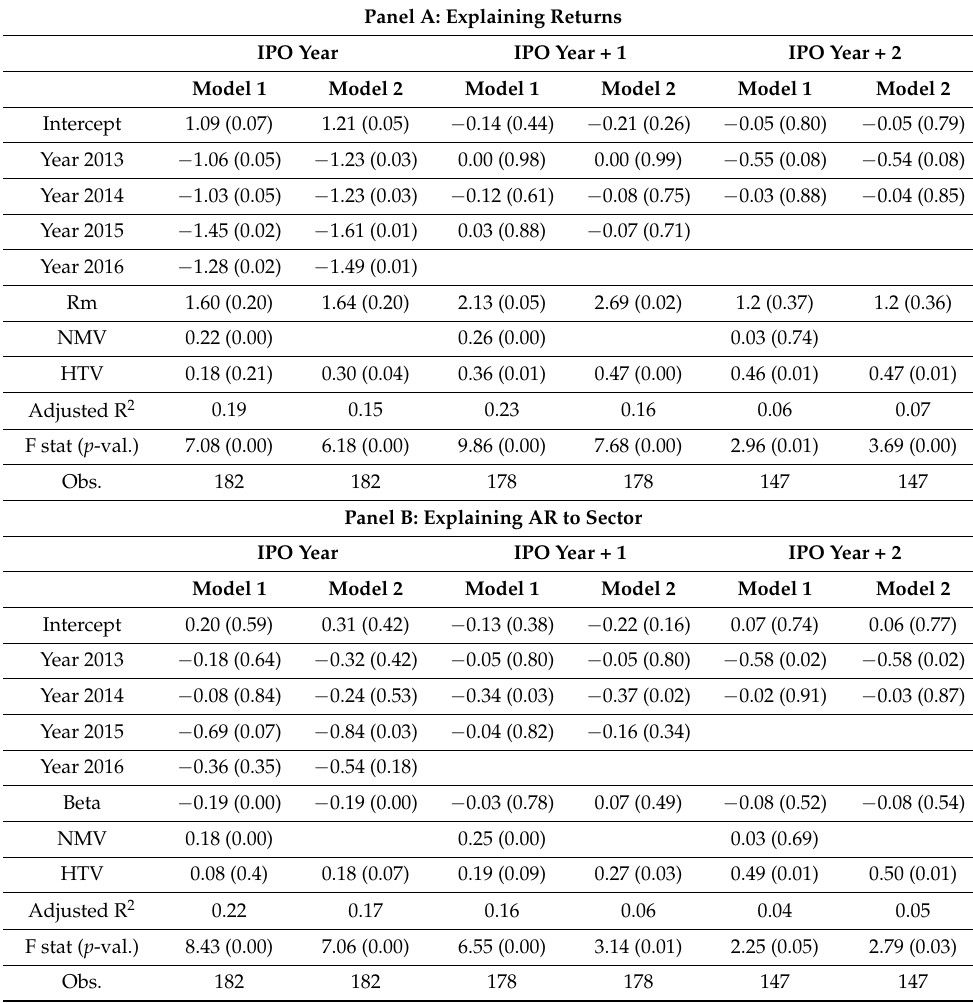
Table 6. The Effects of Tweet Volumes on Returns and Abnormal Returns (AR): Regression Results. Panel A: Explaining